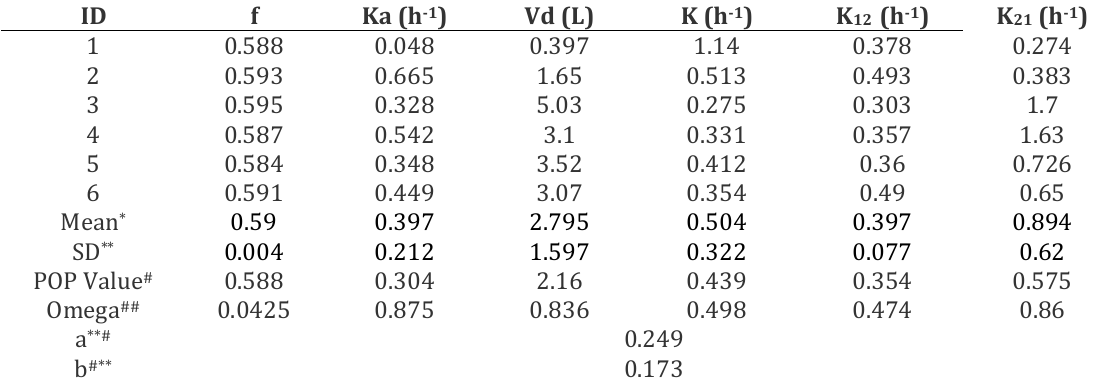
Table II. The estimated parameters values of levofloxacin pharmacokinetics after a simultaneous analysis of intravenous bolus injection and peroral administration